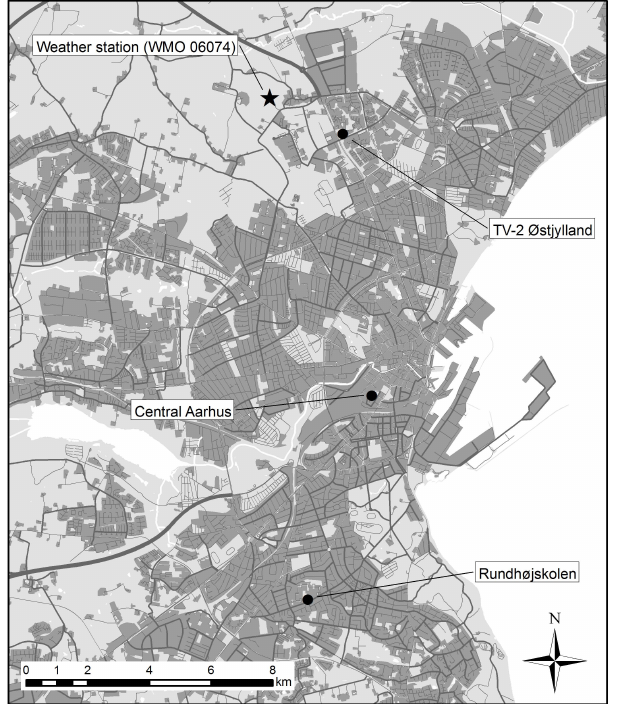
Fig. 1. Map of Aarhus showing the locations of the three temporary pollen monitoring stations and the weather